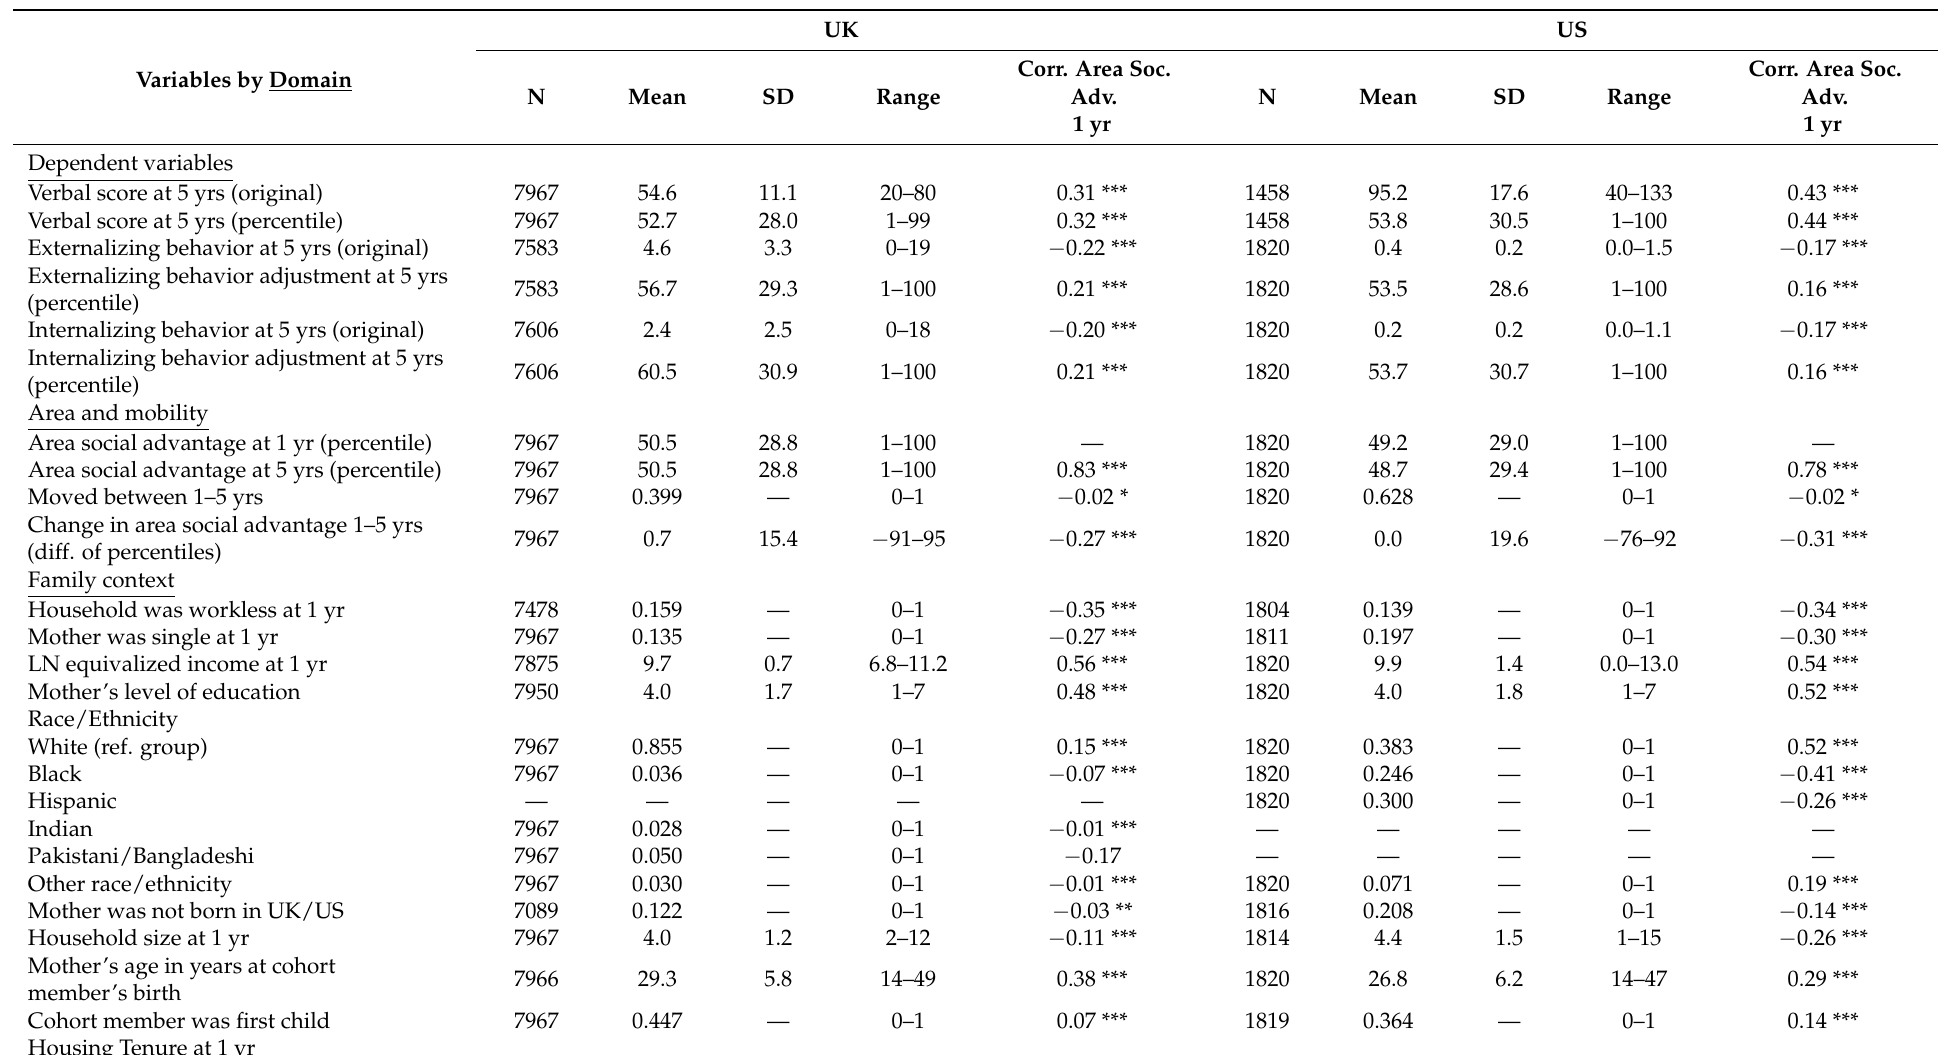
Table 1. Weighted Descriptive Statistics in UK and